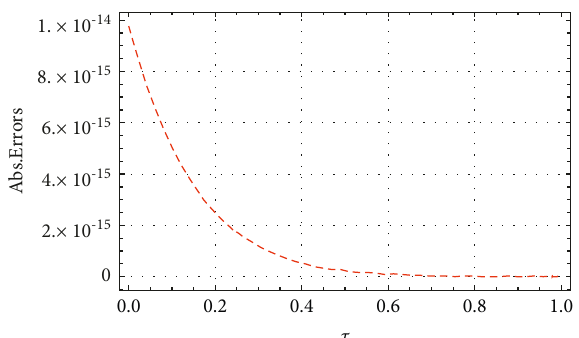
Figure 10: The absolute error for the imaginary part of Example